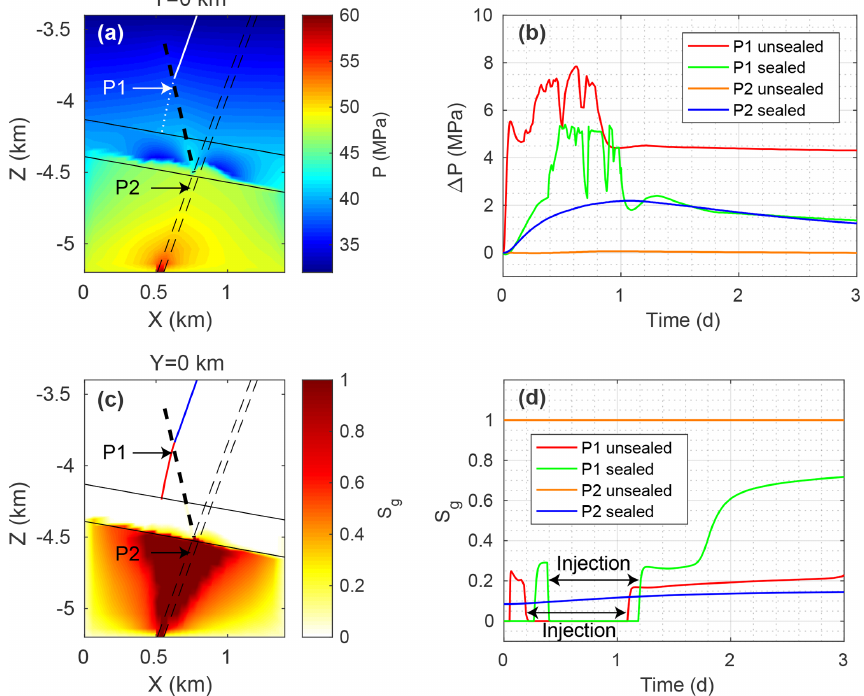
Figure 13. Scenario without a fault seal. (a) Initial pressure conditions at y = 0km (along profile A–A (cid:48) , normal to the fault, in Fig. 2). The well is denoted by the dotted (open section) and solid (cased section) white line. (b) Pressure change with time at the fracture zone/well intersection and on the fault ( z = − 4 . 6km) in comparison to the scenario with a sealing fault. (c) Initial gas saturation at y = 0km (along profile A–A (cid:48) (normal to the fault) in Fig. 2). The well is denoted by the red (open section) and blue (cased section) lines. (d) Gas saturation over time at the fracture zone/well intersection and on the fault ( z = − 4 . 6km) in comparison to the scenario with a sealing fault. (a, c) The fault is illustrated by the thin dashed black lines, the fracture zone by the thick dashed black line, and the caprock by the solid black